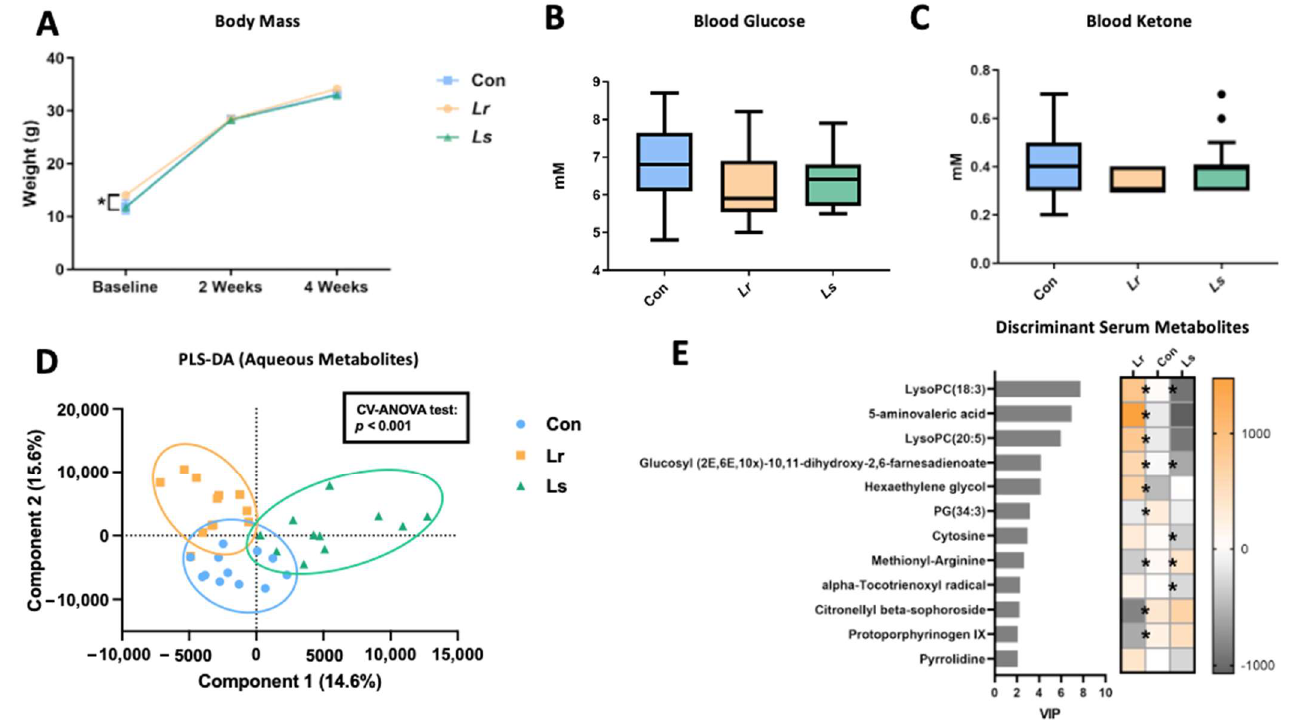
Figure 5. Effect of probiotic treatment on body mass and systemic metabolism. ( A ) Body weight of mice recorded over the 4-week treatment period. Significant differences at baseline were observed between Lr and Ls groups. ( B , C ) Blood glucose and ketone levels measured at sacrifice (N = 17–21) ( D ) PLS-DA analysis of aqueous serum metabolites. ( E ) Discriminant serum metabolites with p < 0.05 and VIP > 2. Significant differences ( p < 0.05) in the abundance of metabolites in the Lr and Ls groups compared to controls determined by Tukey’s post hoc analysis are indicated by ‘*’ on the heatmap. Boxes extend from the 25th to 75th percentiles with the whiskers representing the furthest point that is within 1.5 times the interquartile range (IQR). N= 11–12 mice/group. Con—Control;